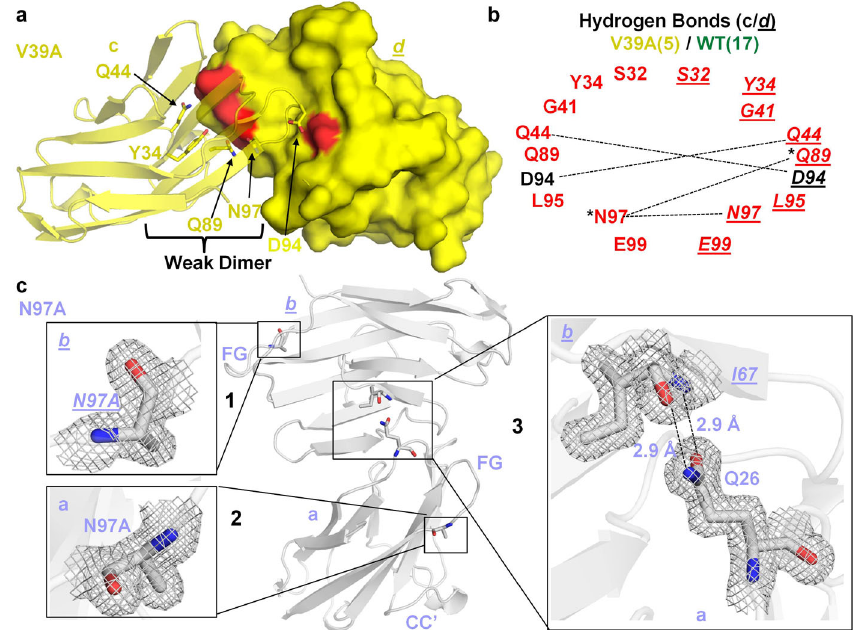
Fig. 5 V39A weak dimer hydrogen bonded interactions and crystal structure of monomeric N97A IgV mutant. a The molecules (c) and ( d ) that mediate formation of a weak GFCC ′ face V39A dimer are shown in ribbon and surface representation in yellow, respectively. The residues Y34, Q44, Q89, D94, and N97, which mediate the hydrogen bonded interactions, are shown in stick representation for molecule (c) and surface bright and light red representations for molecule ( d ). The carbon atoms in yellow, carbonyl oxygen in red and nitrogen in blue, are colored, respectively. b The fewer hydrogen bonded interactions that result in the weak V39A dimer formation between molecules (c) and ( d ) residues of the V39A mutant crystal structure are shown by dashed lines. The residues of molecule ( d ) are shown in italics and underlined, respectively. The lesser quantity of hydrogen bonds at GFCC ′ interface were observed in the V39A weak dimer, 5 (yellow) vs 17 (green) for V39A dimer and WT, respectively. The residues in red indicate loss or decreased number of hydrogen bond interactions in the V39A weak dimer compared to WT. The asterisk (*) indicates the formation of two hydrogen bonds (shown by single dashed line) mediated between N97 residue of molecule (c) and Q89 residue of molecule ( d ). c The crystal structure of N97A mutant with two monomeric molecules (a, bottom) and ( b , top) shown by ribbon diagram colored silver white. The carbon atoms in silver white, carbonyl oxygen in red and nitrogen in blue, are colored, respectively. The insets 1 and 2 shows stick representation of N97A residues of both molecules with electron density (2Fo – Fc map at 1.0 σ level) and this mutation leads to abrogation of GFCC ′ face dimer in the N97A crystal structure. The residues of molecule ( b ) are shown in italics and underlined, respectively. The CC ′ and FG loops are labeled and very limited interface contact between two N97A molecules through ABED face is shown in inset 3, where Q26 of molecule (a) and I67 of molecule (b) participates in hydrogen bonded interaction. The two hydrogen bonds of 2.9Å and 2.9 Å between the aforementioned residues are shown by dashed lines. The residues are shown by stick representation with electron density (2Fo – Fc map at 1.0 σ